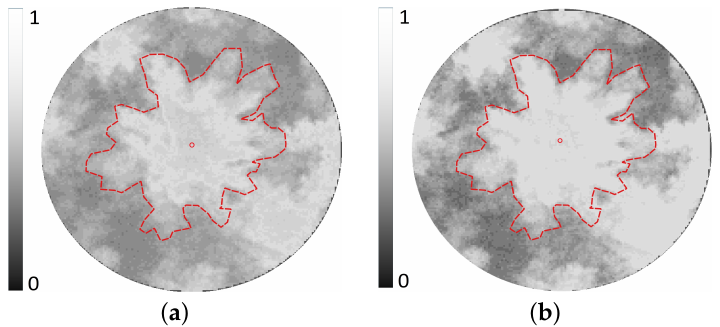
Figure 5. The fractional image u c ∈ [0, 1] obtained for a sample crown using ( a ) the fuzzy C-means (FCM) without spatial contextual term and ( b ) FCM with the spatial-contextual term (i.e., FCM-MRF classifier). The manually extracted reference treetop and crown boundary are shown as red dot and dotted-red line, respectively.